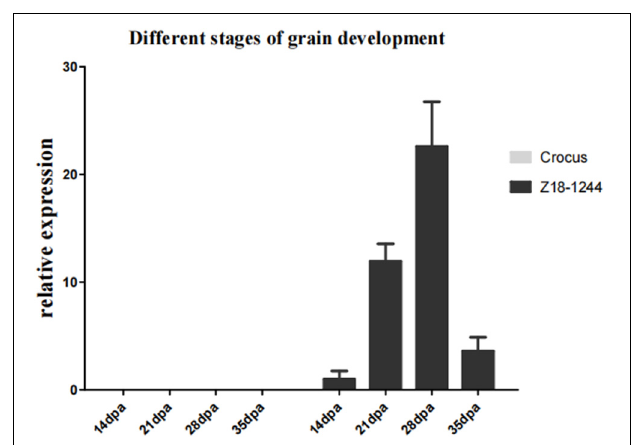
FIGURE 6 | Relative expression of TbMYC4A in the seeds of Z18-1244 and Crocus at different developmental stages.